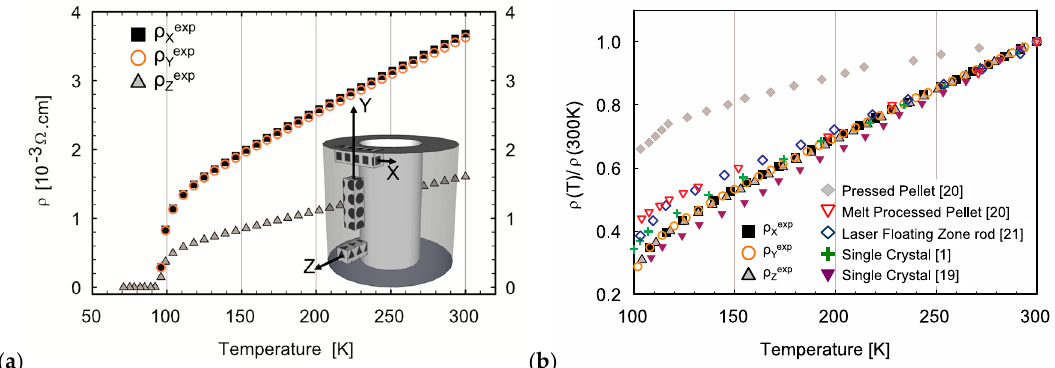
Figure 5. ( a ) Temperature dependence of the resistivity measured on bar specimens cut along the X, Y, and Z directions of the tube (geometry in inset); ( b ) its comparison with the literature data for single crystals [1,19] and Bi-2212 bulk samples processed using other techniques [20,21].